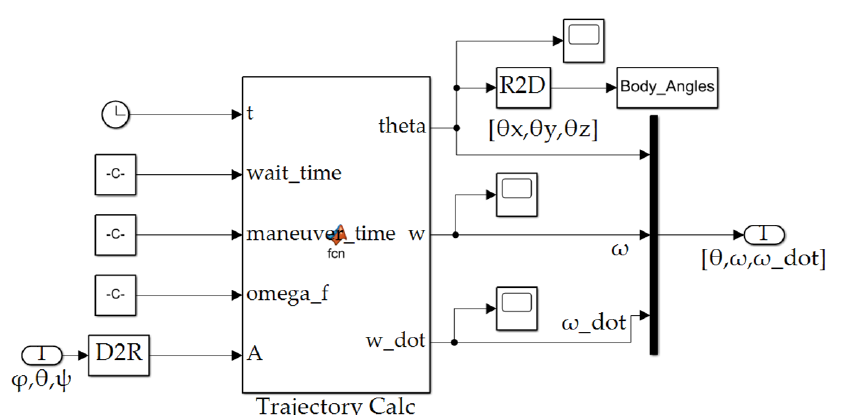
Figure A2. Trajectory subsystem depicted in Figure A1.